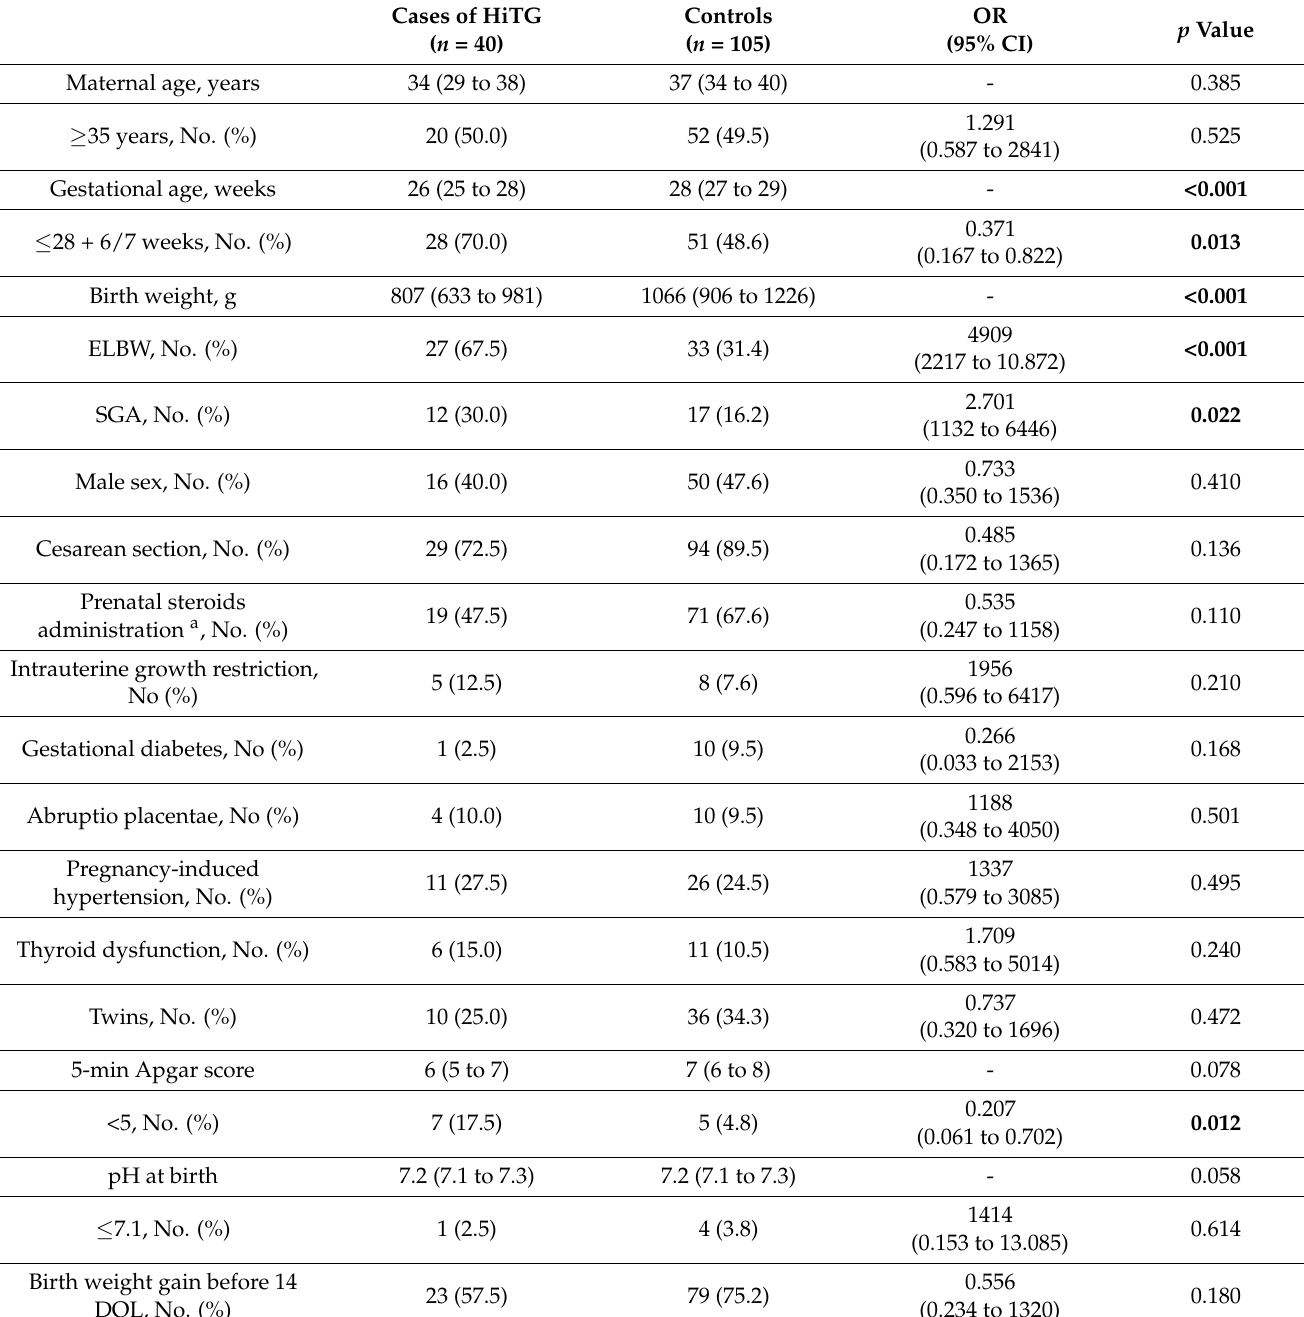
Table 1. Baseline clinical characteristics of neonates with hypertriglyceridemia compared with controls. Cases of HiTG ( n = 40)